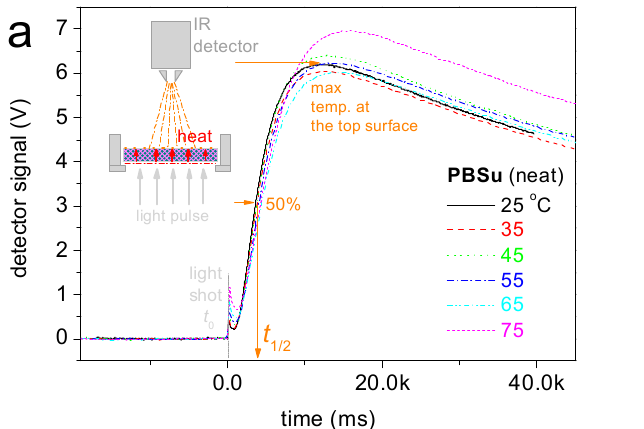
Figure 5. Polarized light microscopy (PLM) images during the time evolution of isothermal crystallization of all samples at 90 °C. The added scale bars correspond to 500 μ m and magnification micro-40.